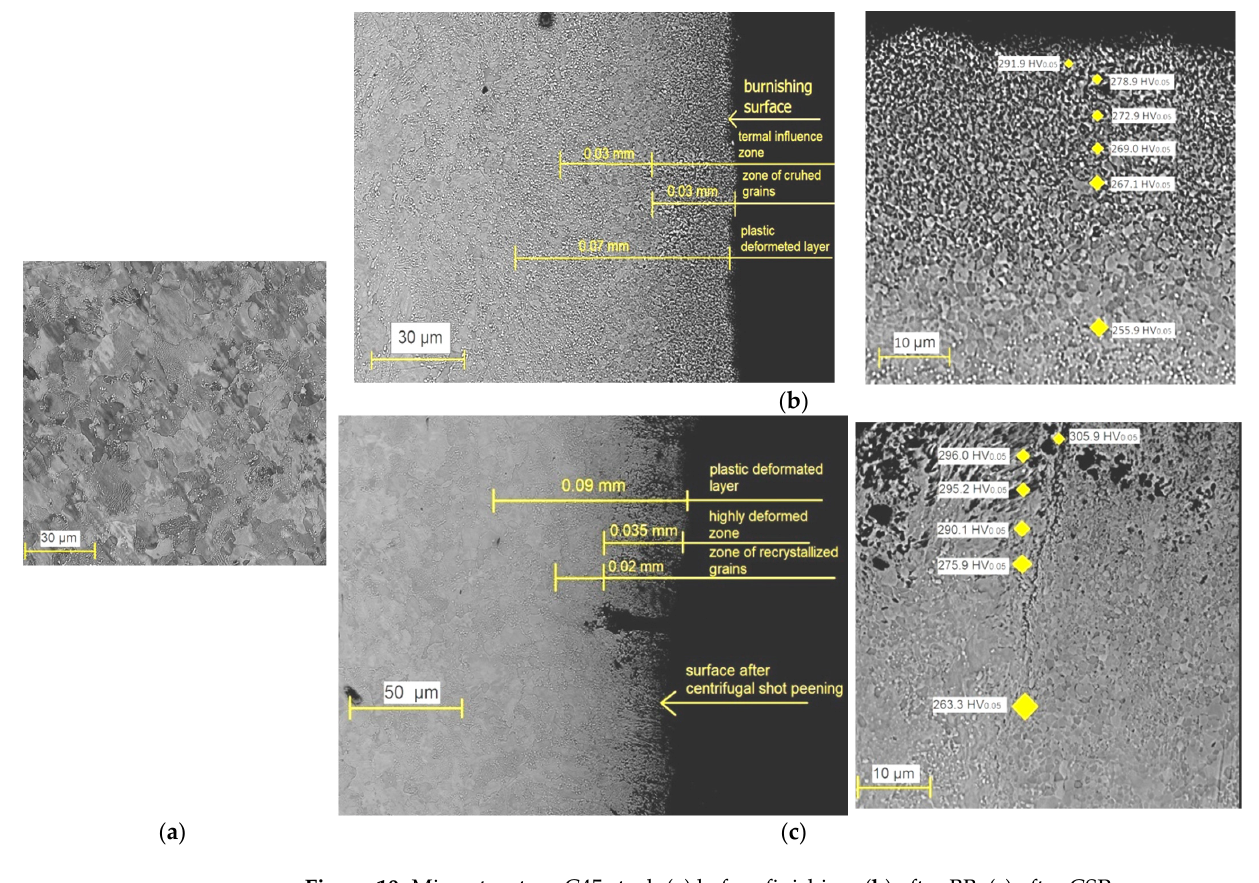
Figure 10. Microstructure C45 steel: ( a ) before finishing; ( b ) after BB; ( c ) after CSP.